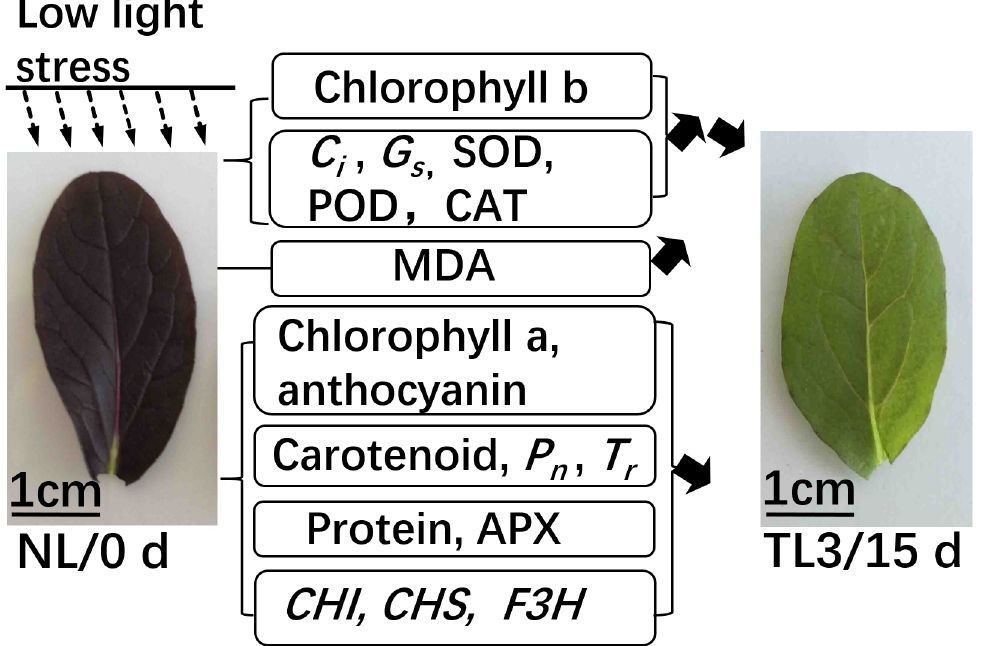
Fig 7. A model of purple pak-choi grown under low light stress. The 45 degreeupwardslopingblack arrow indicatesa rise, and the 45 degreedownward slopingblack arrow indicatesa descent.